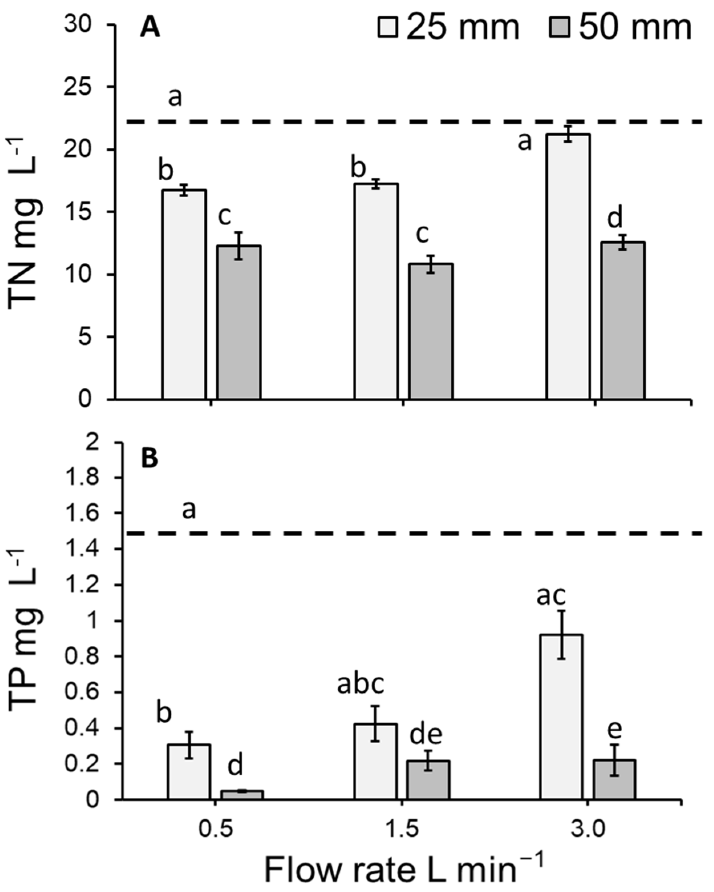
Figure 6. Mean ( ± SE) ( A ) total nitrogen concentration (TN mg L − 1 ) and ( B ) total phosphorous concentration (TP mg L − 1 ) of the hydroponics medium following the cultivate Lemna minor within an indoor, vertically stacked system. As no effect of tray was detected, trays have been pooled in this simplified model depiction. Letters show statistical similarity within each panel ( p > 0.05). Dashed lines represent the initial concentration of TN ( A ) and TP ( B ).